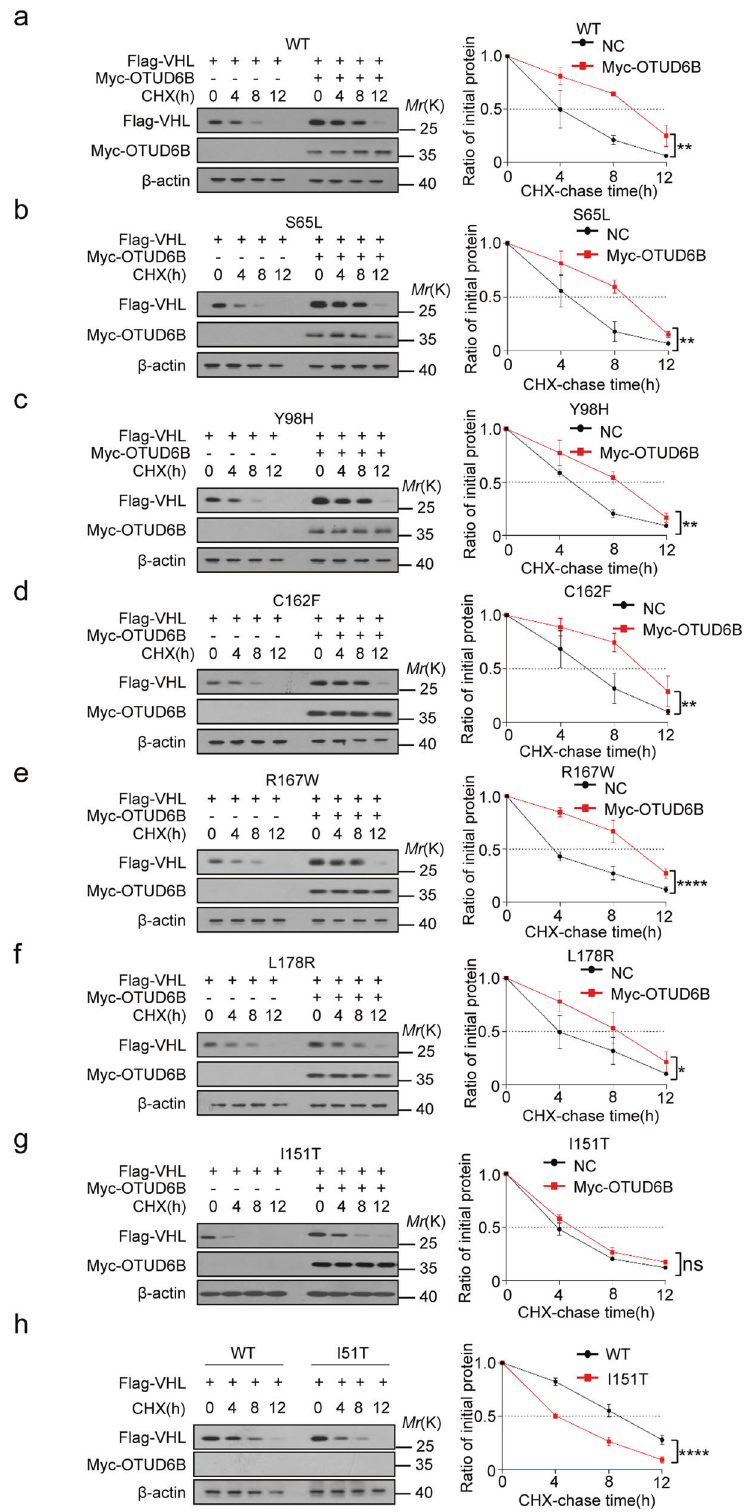
Fig. 5 OTUD6B enhances stability of VHL mutants. a HEK293 Cells was treated with 10 μ g/ml cycloheximide (CHX) for 0, 4, 8, 12 h after transfected with wild type pVHL and OTUD6B for western blot. b – h HEK293T treated with 10 μ g/ml CHX after transfected with indicated pVHL mutants and OTUD6B was gathered at the indicative hours for immunoblotting. Quanti fi cation of pVHL levels relative to β -actin is shown. * P < 0.05, ** P < 0.01, **** P < 0.0001, two-way ANOVA test.